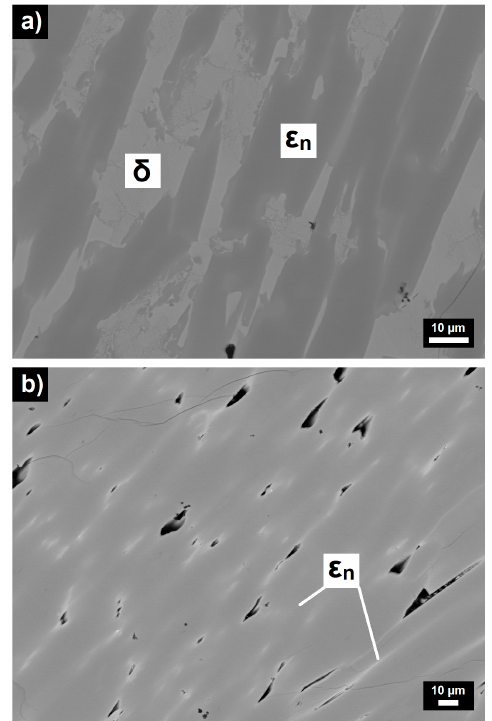
Figure 2. BEI / SEM images of microstructure constituents in as-solidified Al 70 Pd 25 Co 5 ( a ) and Al 74 Pd 12 Co 14 ( b ) alloys. Black areas in ( b ) correspond to pores. Phases assigned to particular constituents are also marked.